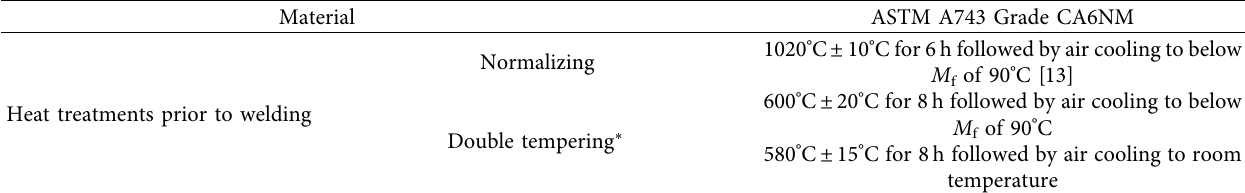
Table 1: As-received material heat treatment conditions prior to welding.